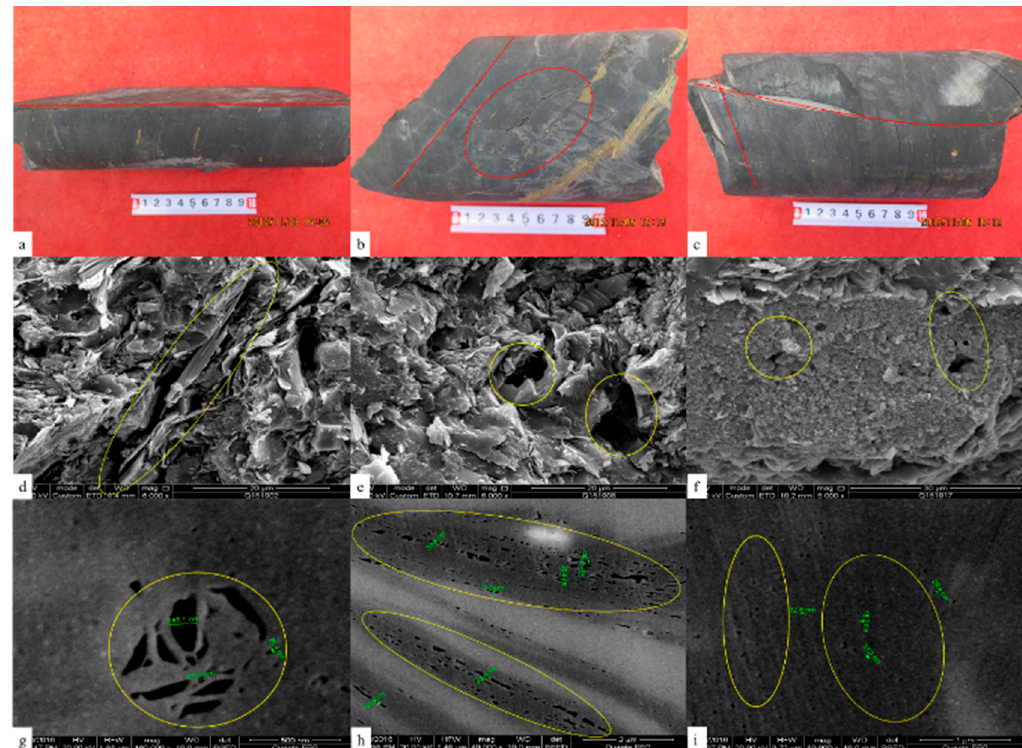
Figure 7. The reservoir storage-space types of Xinkailing shale in Wuning: ( a ) vertical shearing crack; ( b ) diagenetic shrinkage joint and interlayer lamellation seam; ( c ) vertical shearing crack and interlayer lamellation seam; ( d ) pore (crack) between clay minerals; ( e ) intergranular dissolution pore; ( f ) pyrite intergranular pore; ( g ) organic matter pore; ( h ) organic matter pore; ( i ) organic matter pore.